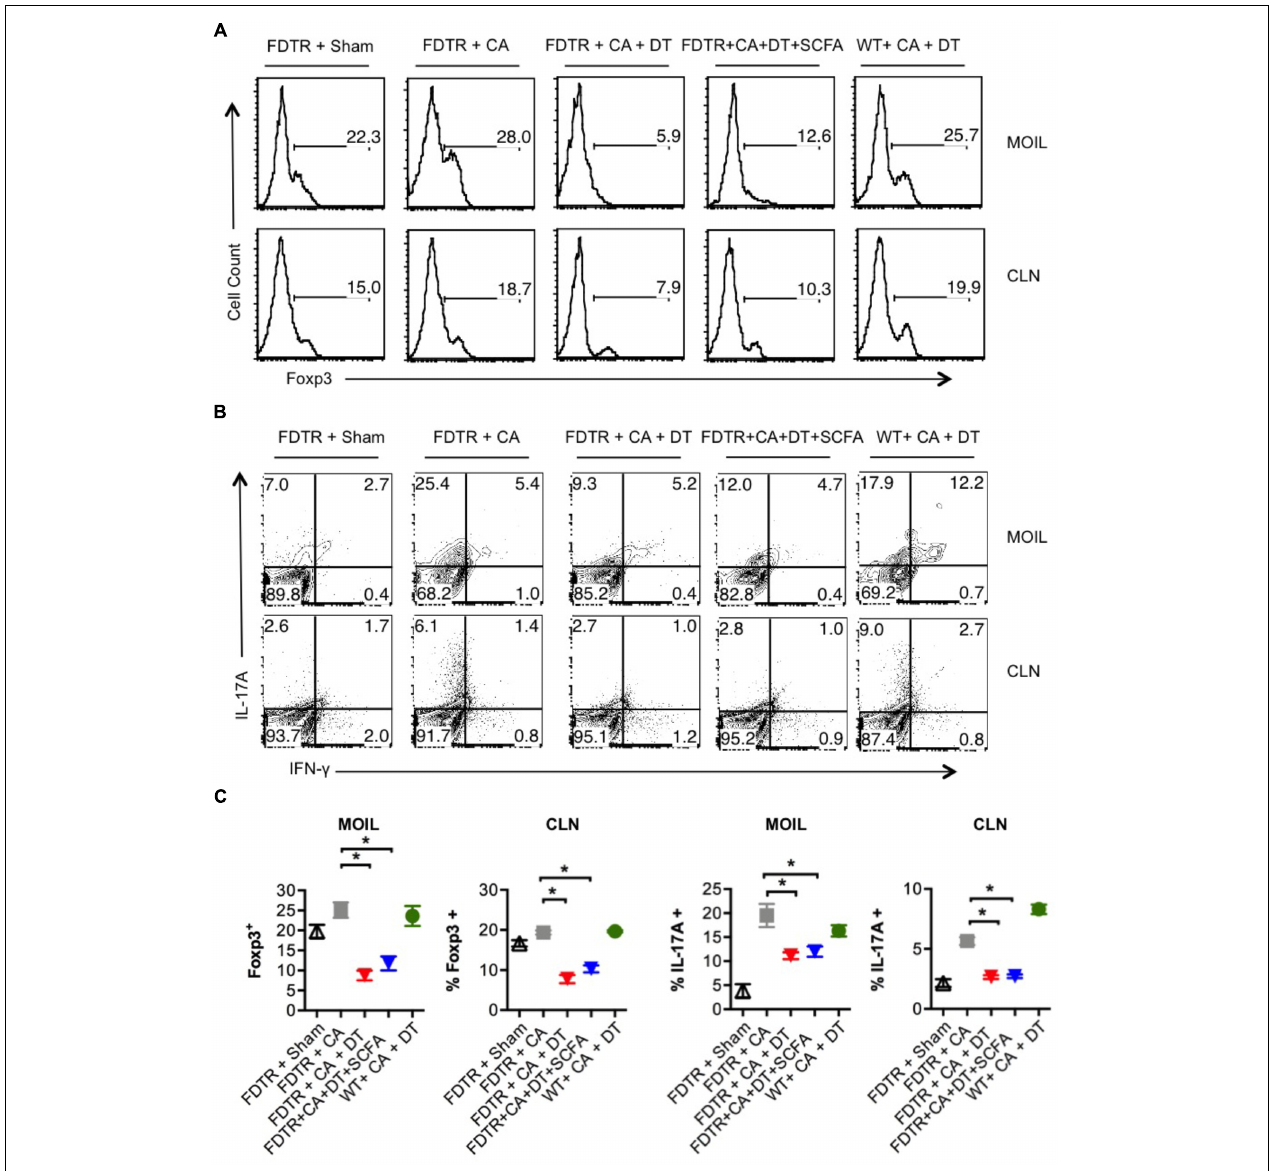
FIGURE 6 | SCFA mediated induction of T regs enhances the frequency of IL-17A producers in CA infected mice. (A) FDTR and WT mice were pre-injected with DT, or pretreated with SCFA as in Figure 5 . On day 7 after infection, mice were re-infected with CA, MOILs and CLN were harvested. Flow cytometric analyses of intracellular staining of Foxp3 expression (A) , and IFN- γ and IL-17A in CD4+ T cells are shown (B) . (C) Statistical analyses for % Foxp3+ or % IL-17A+ cells ( n = 4/group) was performed using Mann–Whitney test ( ∗ P < 0.05). Mean ± SEM are shown. Results represent data from 3 independent